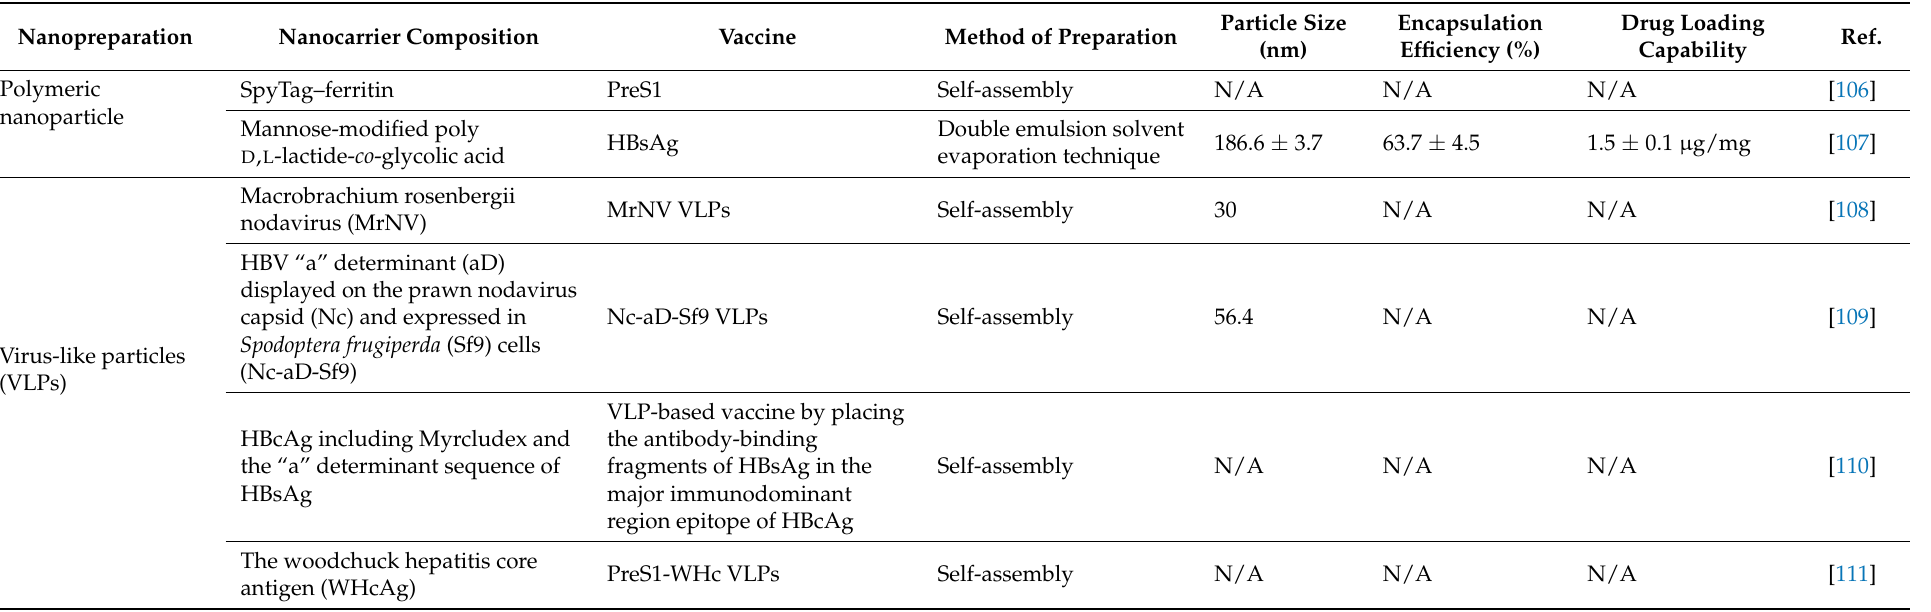
Table 3. Composition and properties of nanoparticle delivery systems for anti-HBV